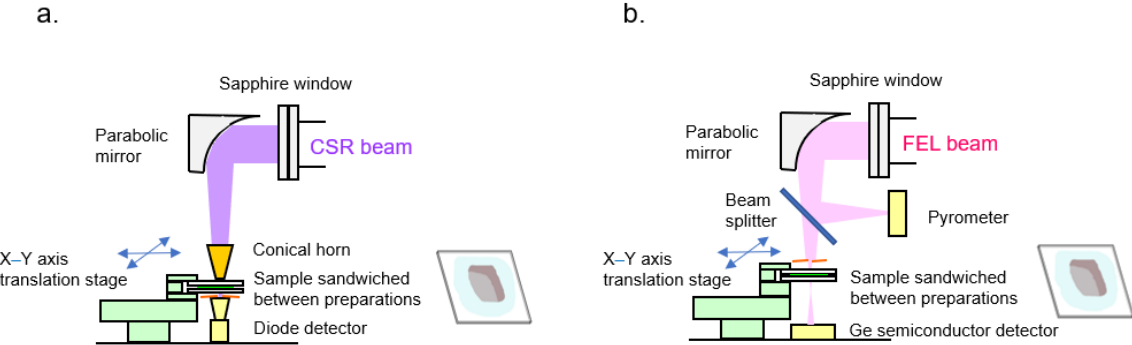
Figure 2. Schematic layout of the ( a ) terahertz imaging system and ( b ) infrared free-electron laser imaging system.